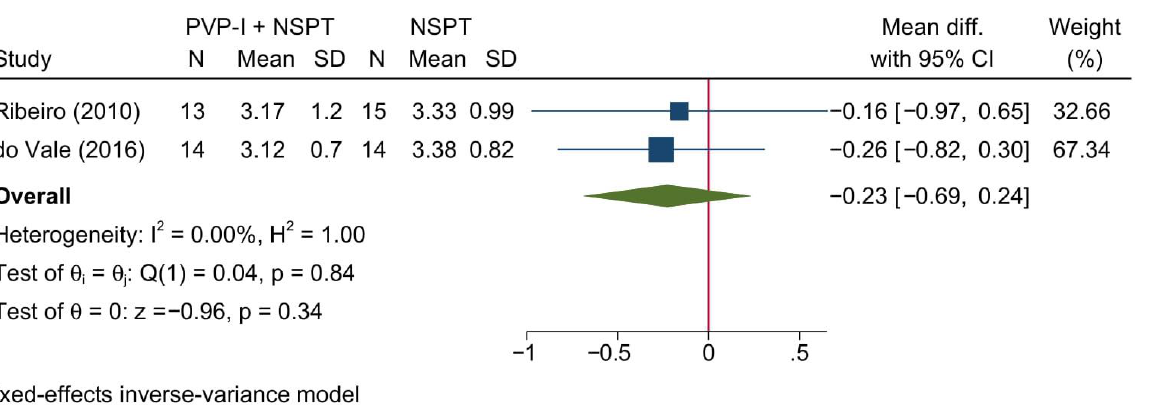
Figure 10. Forest plot showing the comparison between PVP-I + NSPT and NSPT alone regarding BAPNA [31,46]. Upon doing a subgroup analysis based on the assessment timepoint, no significant differences were found between both groups at 1, 3, and 6 months [Supplementary Figure S9]. 3.5. Meta-Analysis Outcomes [NaOCl+ NSPT vs. NSPT Alone] 3.5.1. Probing Depth of Pockets